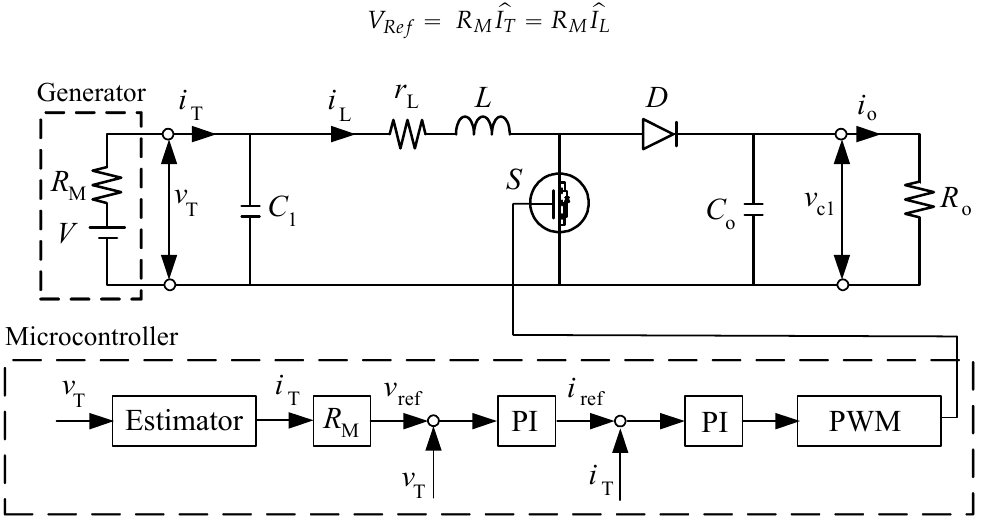
Figure 9. Configuration of the system using a DC/DC boost converter. R M : machine resistance; PI: proportional-integral; PWM: pulse width modulation.